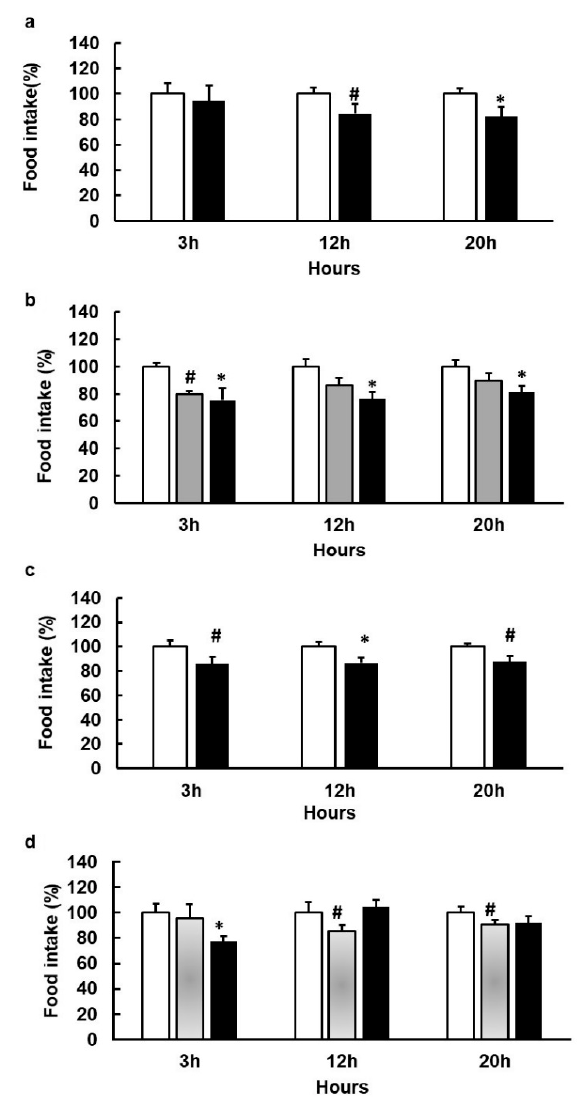
Figure 4. Food intake (FI) changes induced by acute doses of agonists of bitter taste receptors in female rats. Animals ( n = 8–10 / treatment) were treated one hour before dark period with an acute dose of 1,10-Phenantroline 200 mg / kg~290 µ M (black columns) ( a ); 244 mg / kg~0.84 mM epicatechin (grey columns) or 300 mg / kg~1 mM epicatechin (black columns) ( b ); epicatechin + B2 + ECg (200 + 62 + 18 mg / kg) (black columns) ( c ); vanillic acid (252 mg / kg), grey columns) or Vanillic acid (252 mg / kg) + epicatechin (244 mg / kg) (black columns) ( d ); tap water as vehicle (white columns). Food intake was measured at the times indicated after the start of the dark period starts (Mean ± SEM). * denotes p < 0.05 vs. control; # indicate p < 0.1 vs. control.